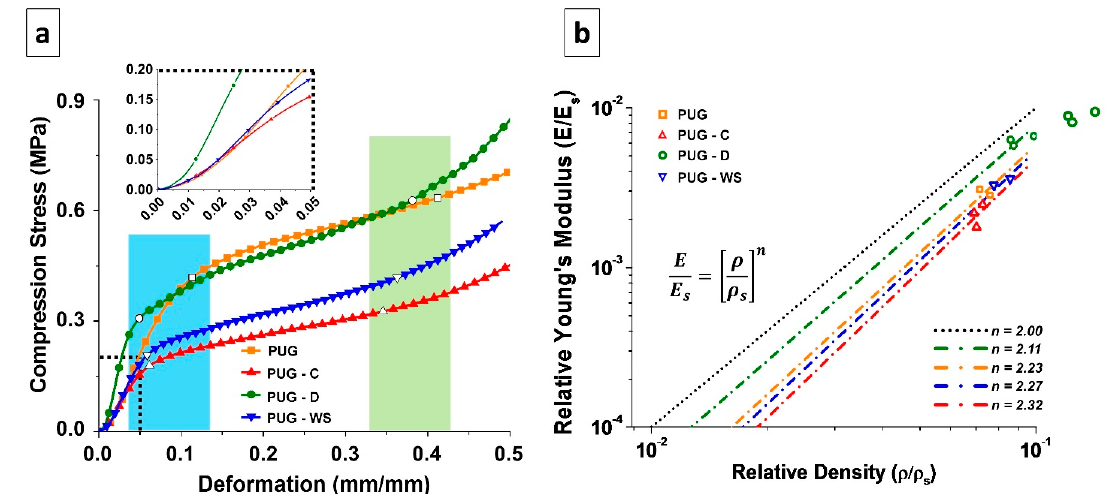
Figure 6. ( a ) Stress-strain curves and ( b ) graphical representation of Gibson-Ashby model of the foamed materials. Table 6. Mechanical and structural properties of the foams.